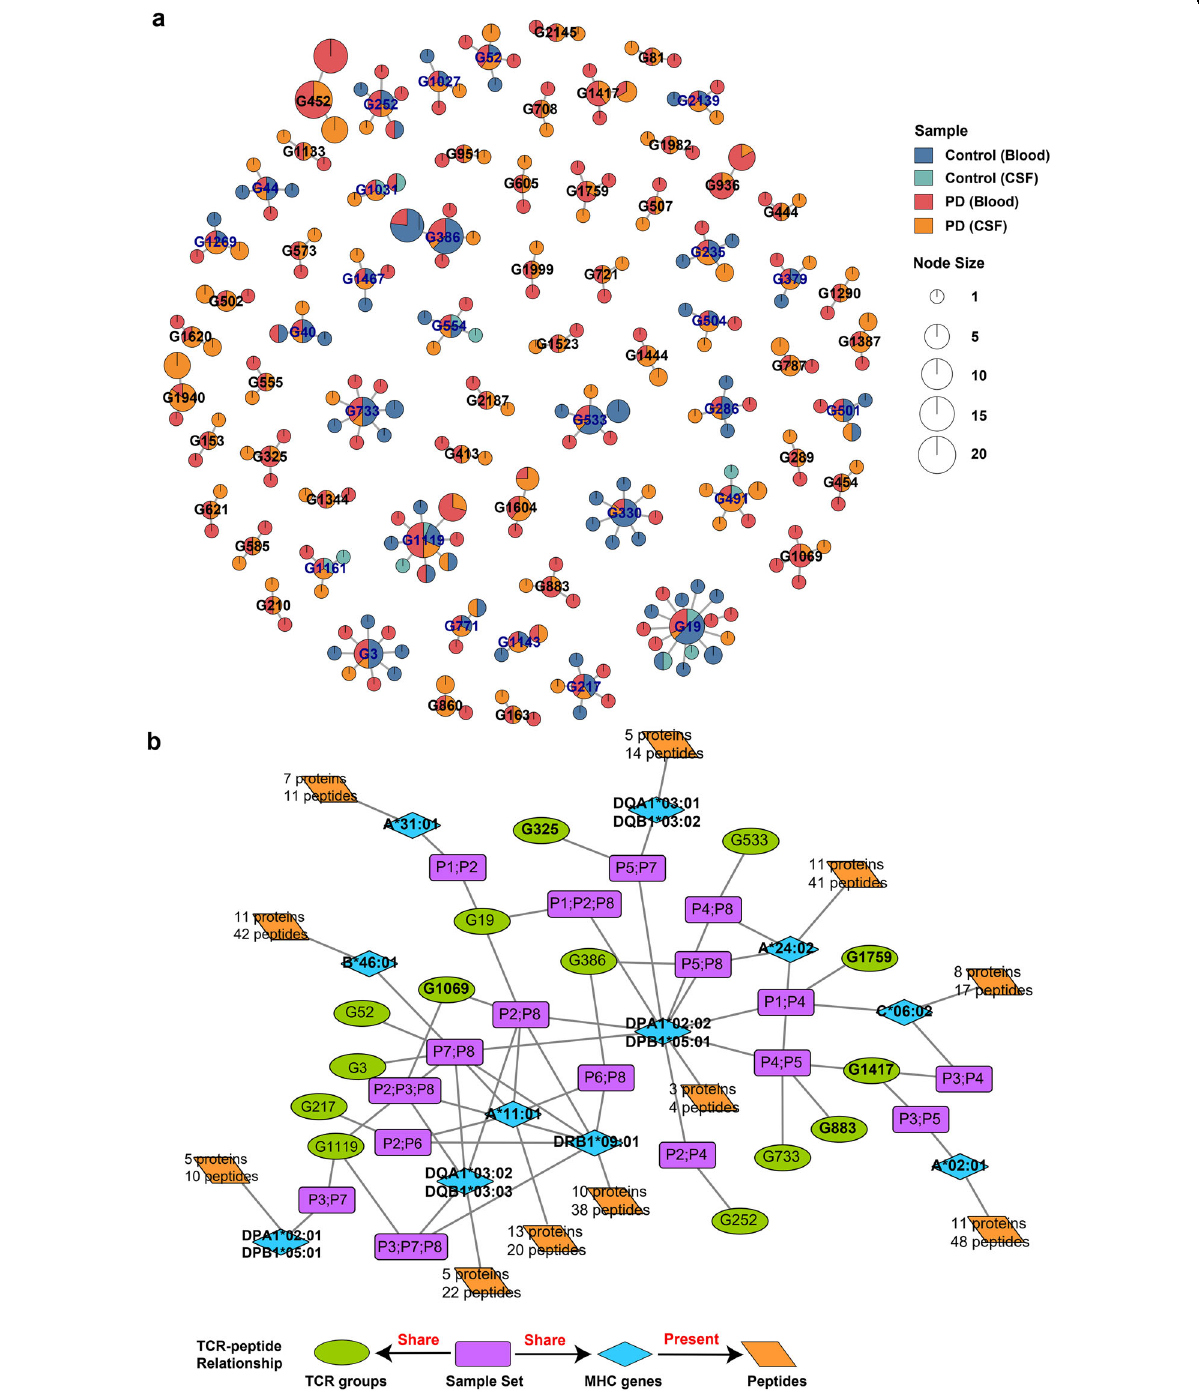
Fig. 5 Antigen-speci fi c TCR groups in PD. a Network plot showing the 67 TCR speci fi city groups with at least one cell from the blood and one cell from CSF of PD patients. Most of the TCR groups were found only in PD patients. b Strong sample sharing relationships between 14 TCR speci fi city groups and 11 HLA alleles. For example, G1759 contains TCRs from patient P1 and P4, and patient P1 and P4 also have the same allele of HLA-C06:02. Thus, the relationship between G1759 and HLA-C06:02 can be constructed through the overlap of sample sets (such as P1 and